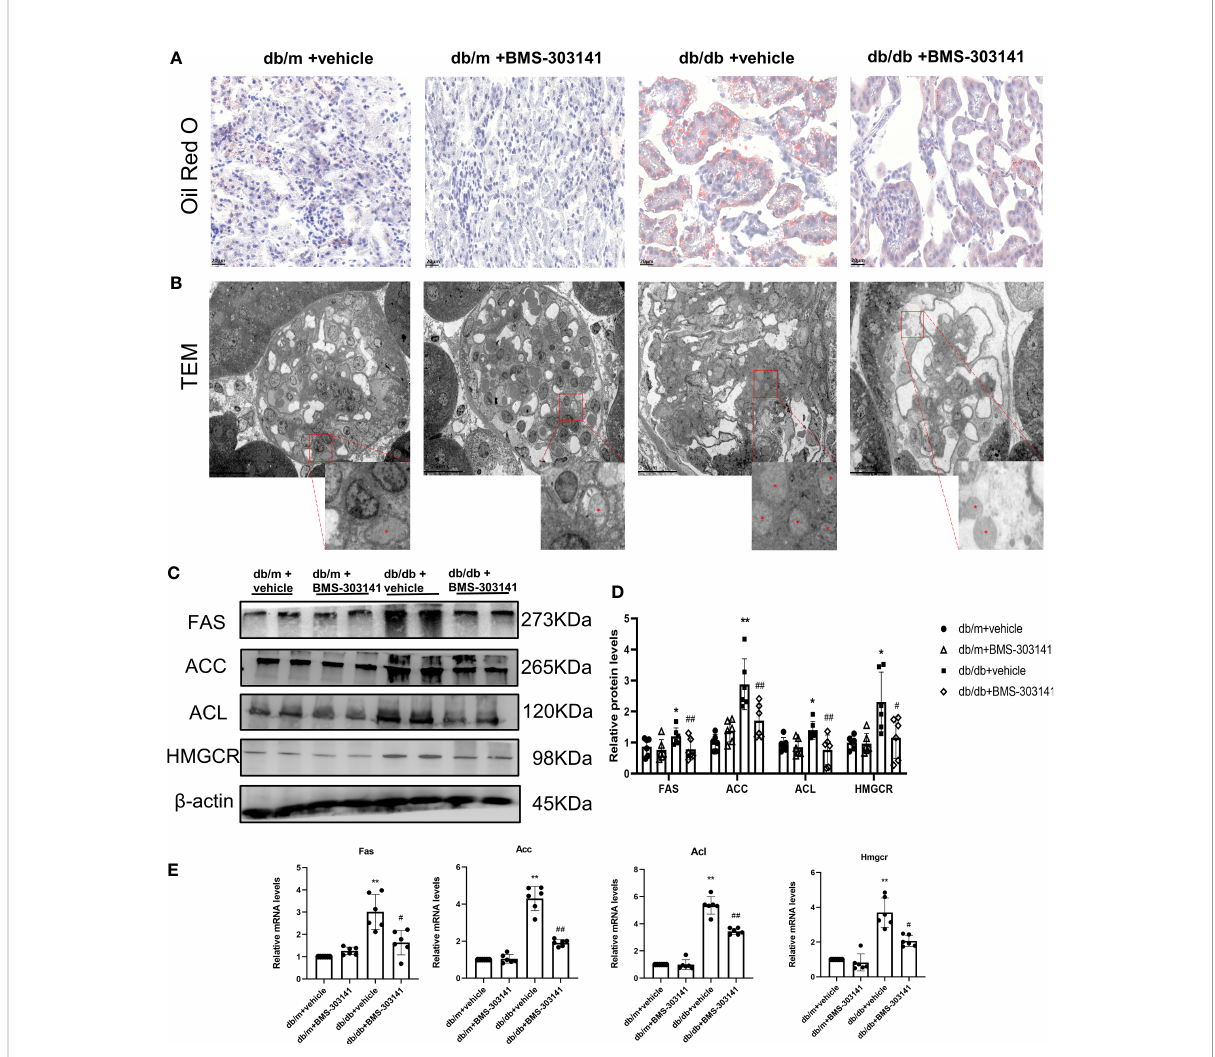
FIGURE 3 Effects of BMS-303141 on renal ELA and the modulation of critical lipogenic and fi brotic genes. (A) Representative kidney cortex sections- related staining Oil Red O (magni fi cation 400x) from db/m and db/db mice for 16 weeks; (B) Transmission electron microscopic examination of glomeruli (magni fi cation 500x). The magni fi ed images are the boxed regions, lipid droplets are marked with asterisks (*). C&D) Western blots (C) and densitometric semiquantitation (D) of speci fi ed proteins in the kidney cortex from db/m and db/db mice; *P < 0.05, **P < 0.01 versus db/m + vehicle;#P < 0.05, ##P < 0.01 versus db/db + vehicle group, n = 6 per each group; (E) Quantitative real-time PCR analysis of Acl, Hmgcr, Acc , and Fas transcripts in the kidney cortex of db/m and db/db mice, *P < 0.05, **P < 0.01 versus db/m + vehicle; #P < 0.05, ##P < 0.01 versus db/ db + vehicle group, n = 6 per each group. The mean ± SD is represented by each bar in the four independent